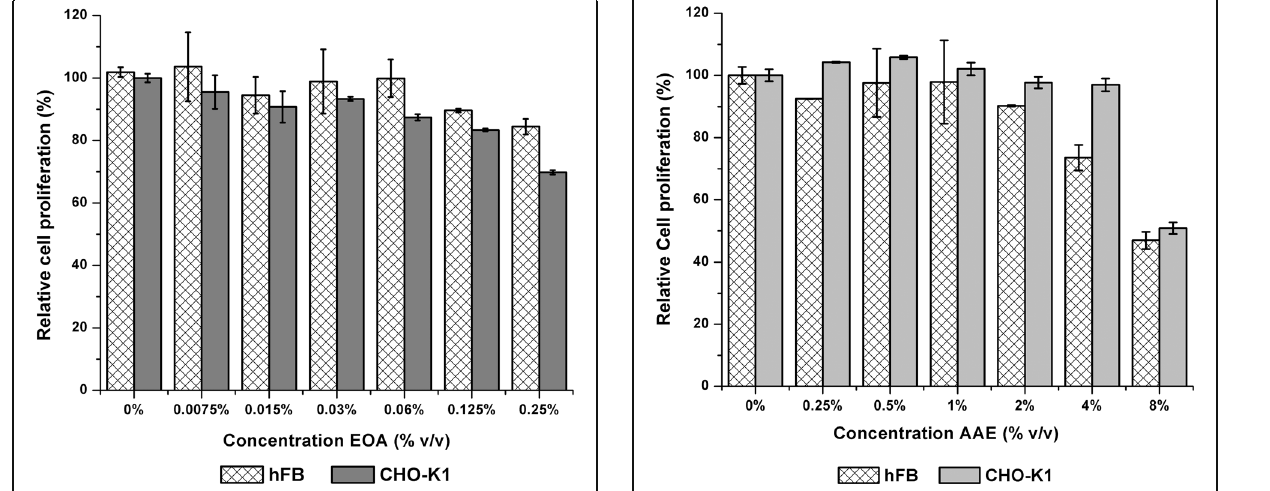
Fig. 1 Effect of essential oil (EOA) on cell lines CHO-K1 and hFB by the MTT test. Error bars represent standard deviation